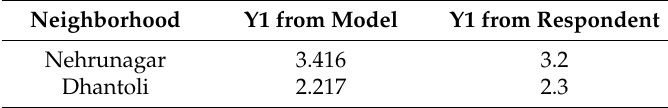
Table 11. Shows the validation results on 2